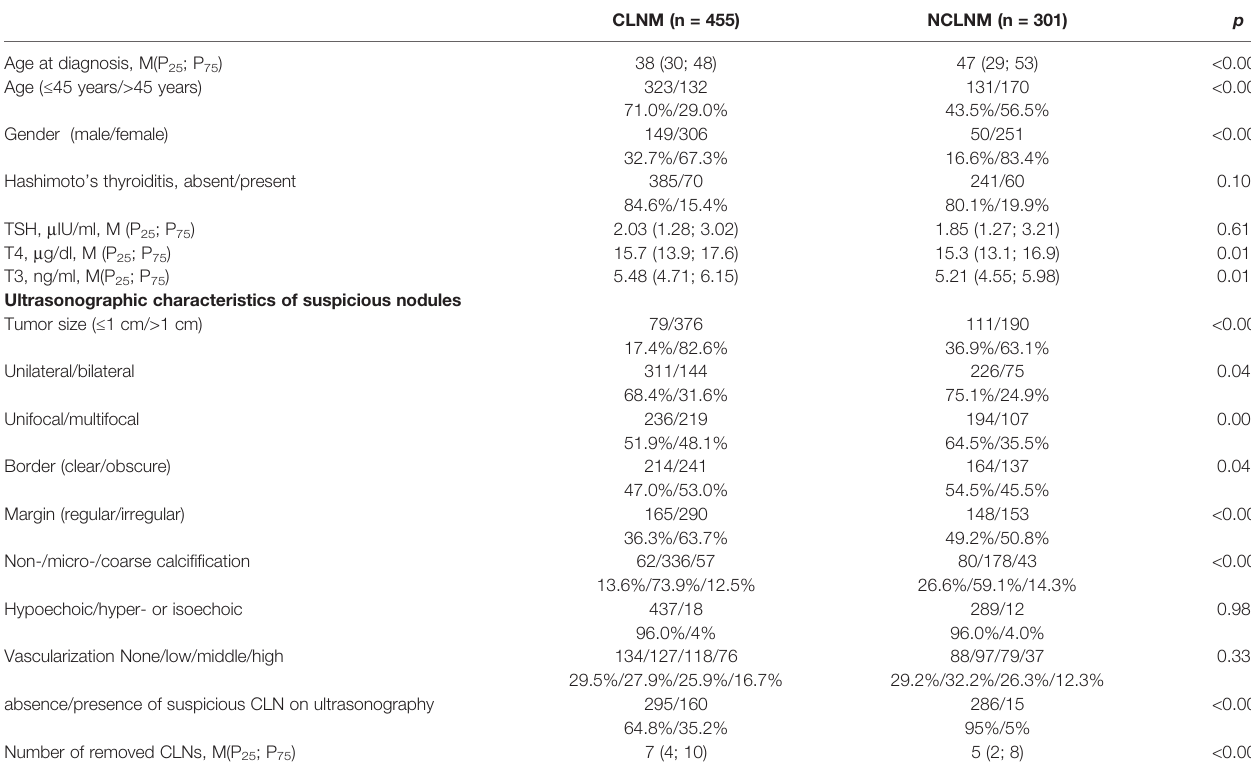
TABLE 3 | Univariate analysis of the correlation between clinical factors of the primary tumor and rate of CLNM in PTC